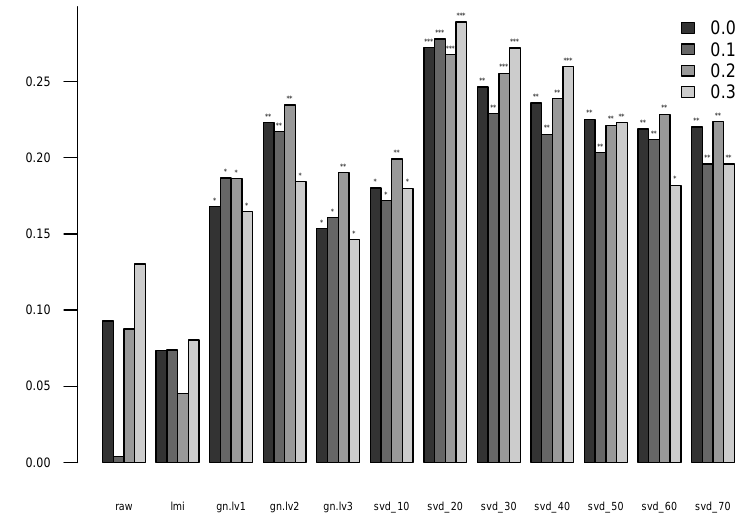
Figure 7: Results across thresholds,